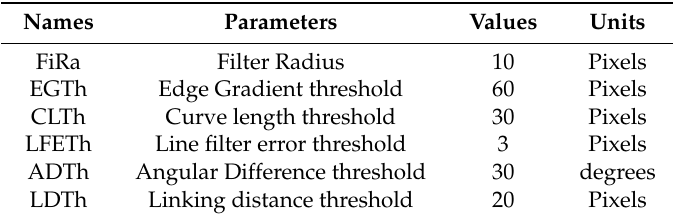
Table 1. Automatic extraction parameterization element.